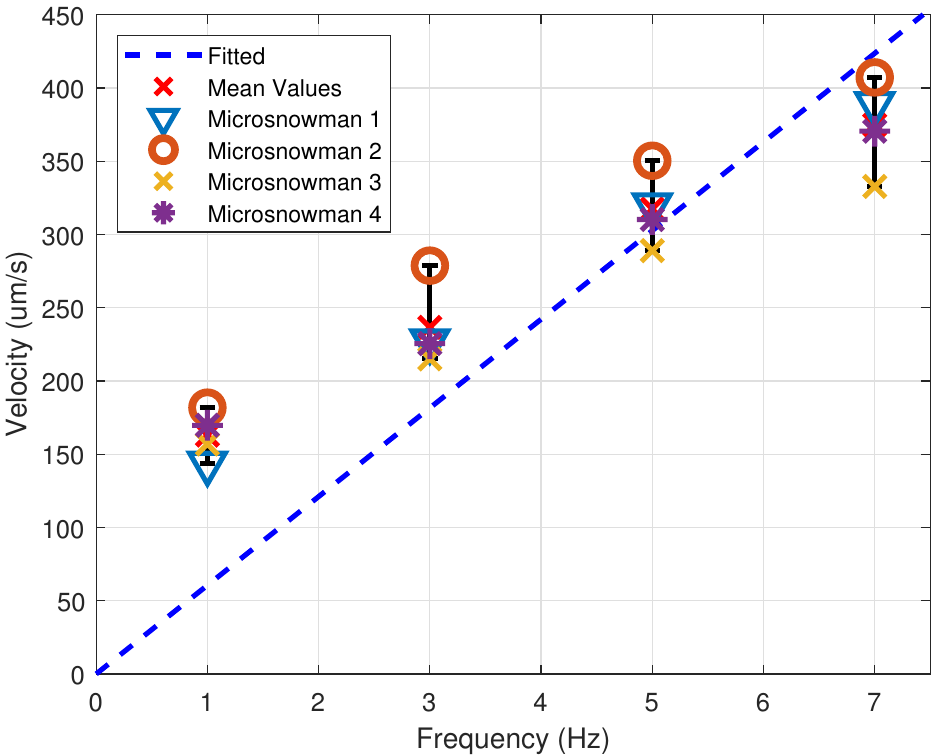
Figure 3. Velocity vs. Frequency plot for four different soft microsnowmen with a linear fit for mean velocity. Error bars are represented with black